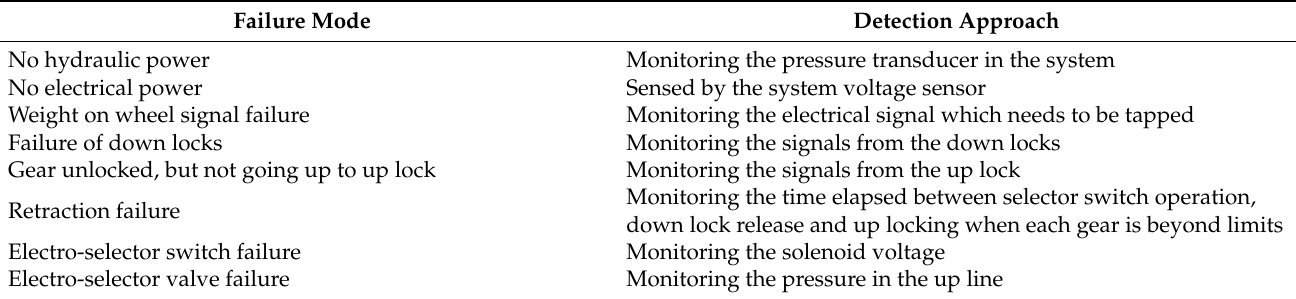
Table 11. Landing gear failure modes and suited detection approach [165].